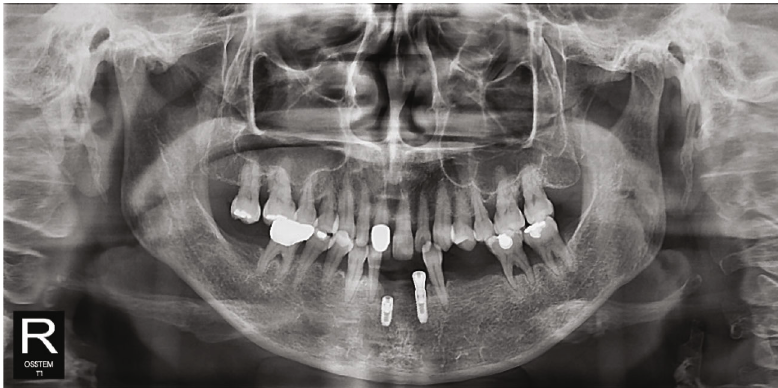
Figure 6: Pre-operative panoramic view (Case 2).